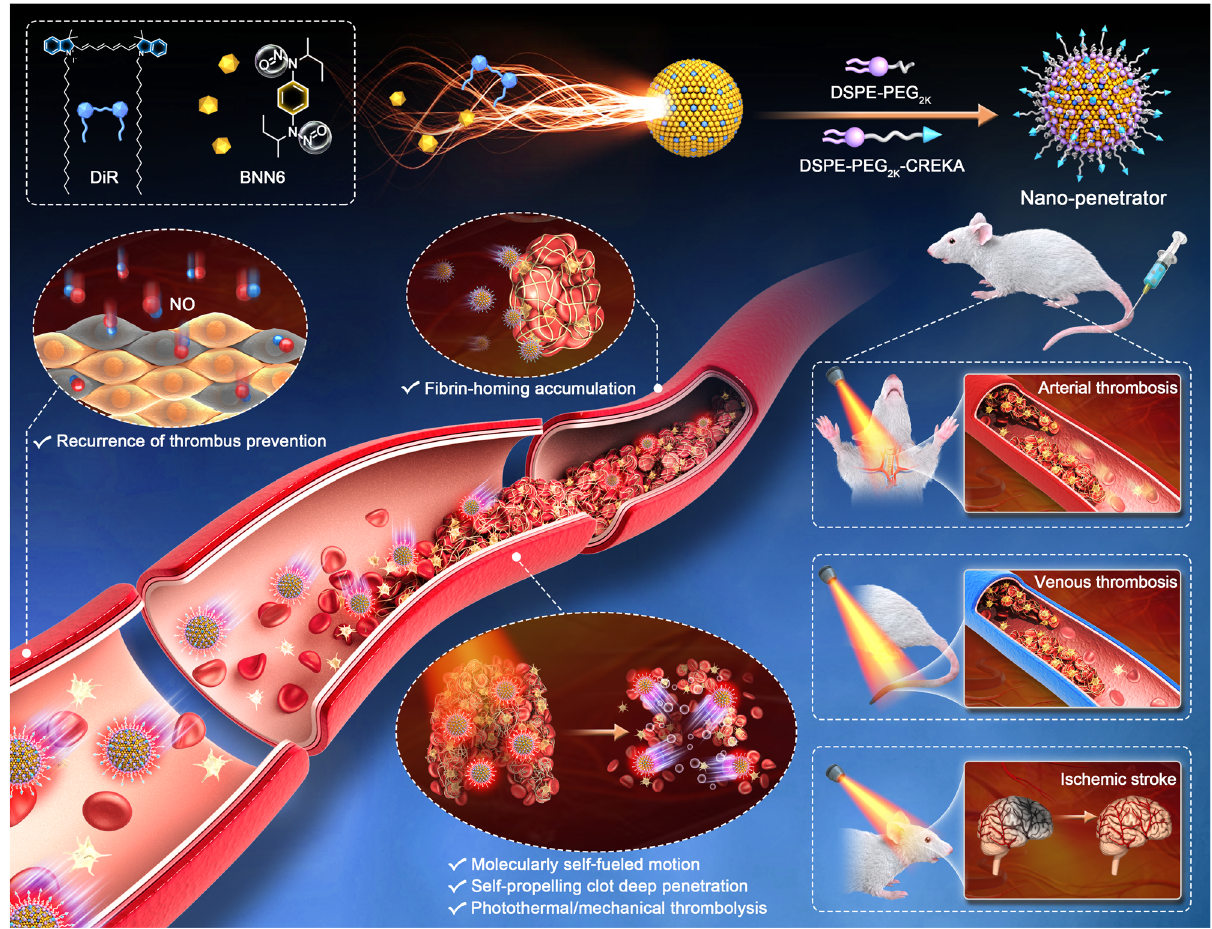
Fig. 1 | Schematic of molecularly self-fueled nano-penetrator for non- pharmaceutical treatment of thrombotic diseases. The molecularly engineered nano-penetrator was self-assembled by BNN6-DiR fuel pair without the assistance ofanycarriermaterials.AfterPEGylationand fi brin-homingdecoration,suchaself-